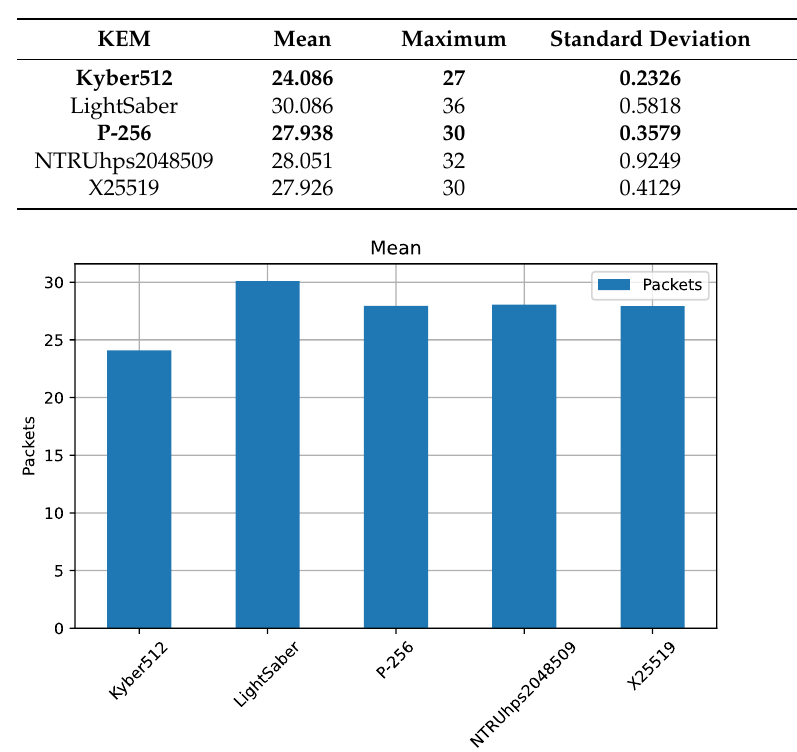
Figure 7. The maximum number of packets transmitted during the connection. LightSaber required the maximum number of packets to transmit during the connection, while Kyber512 used the least. Table 8 shows the 95% CI of the number of packets